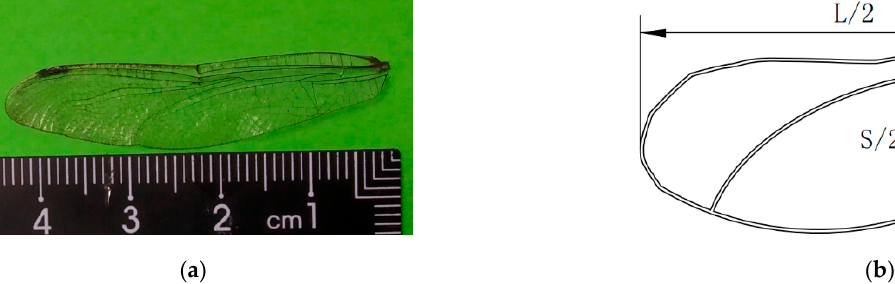
Figure 2. The morphology of dragonfly’s forewing and its bionic model. ( a ) Dragonfly front wing; ( b ) bionic front wing model and size. Table 2. Bionic serration microstructure parameters ( μm ).